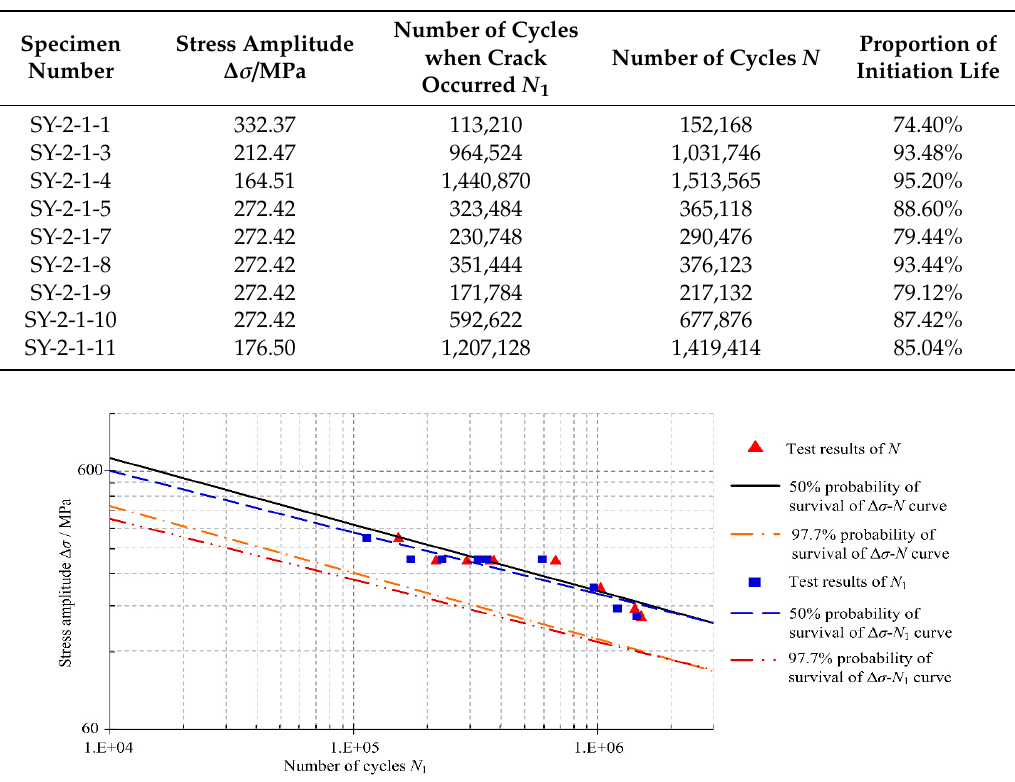
Table 6. The proportion of initiation life for each specimen.